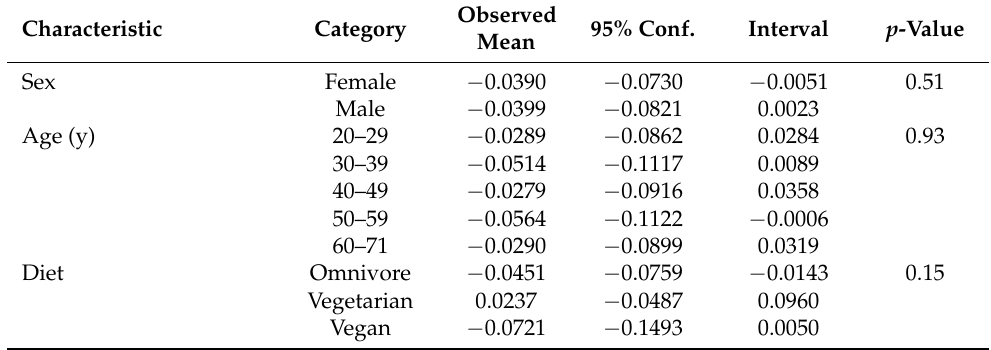
Table 2. The observed OPEA mean and association with the participants’ characteristics (N =